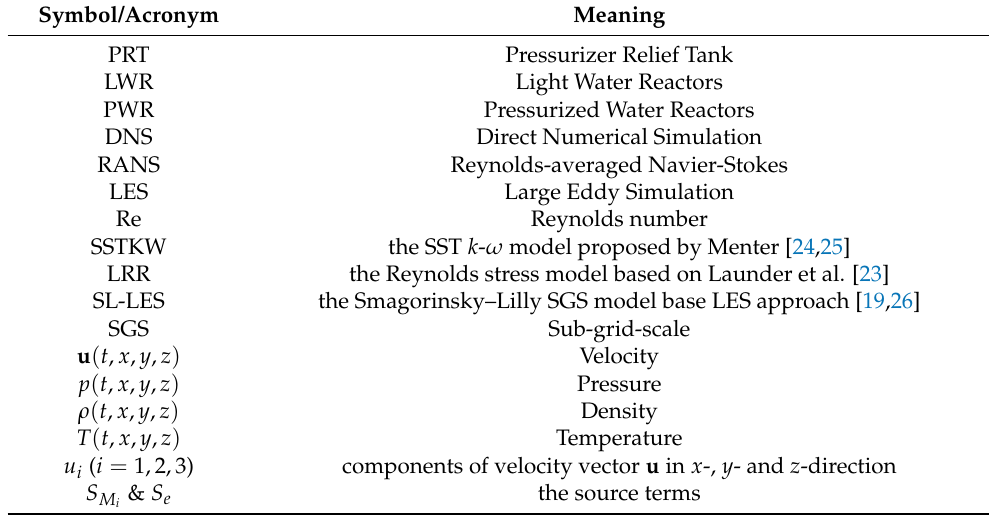
Table A1. The list of symbols and